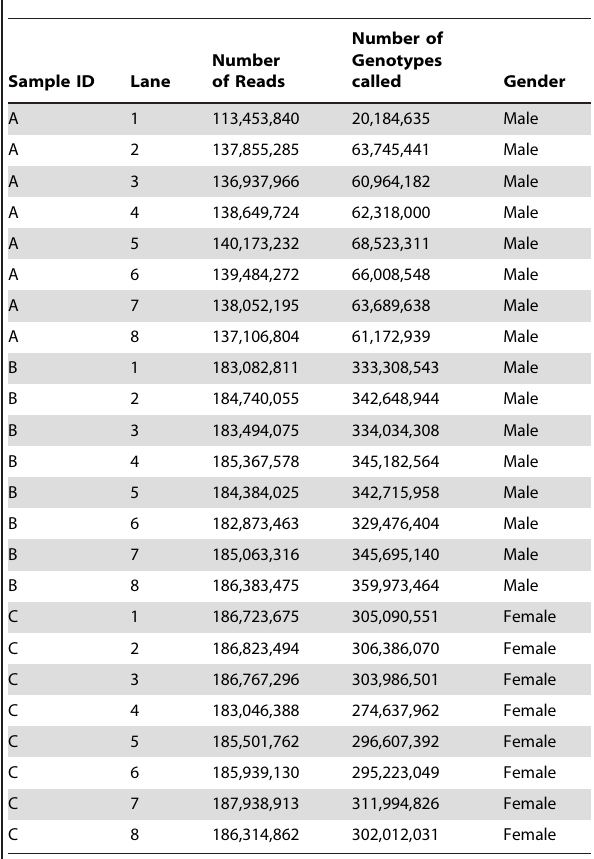
Table 1. Summary of data used in these analyses.